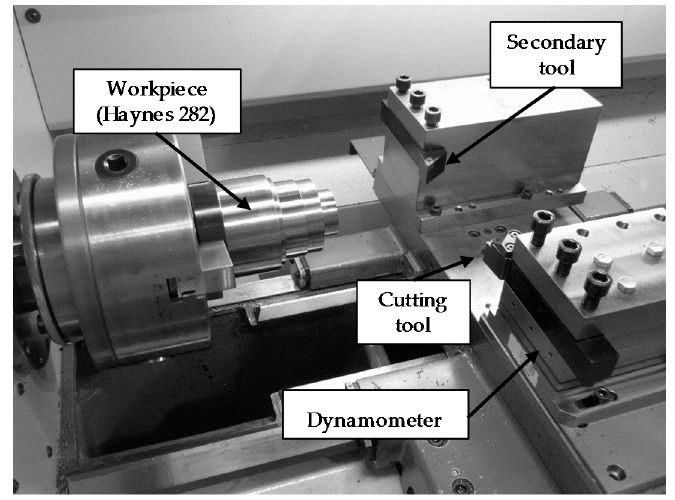
Figure 1. Experimental setup.